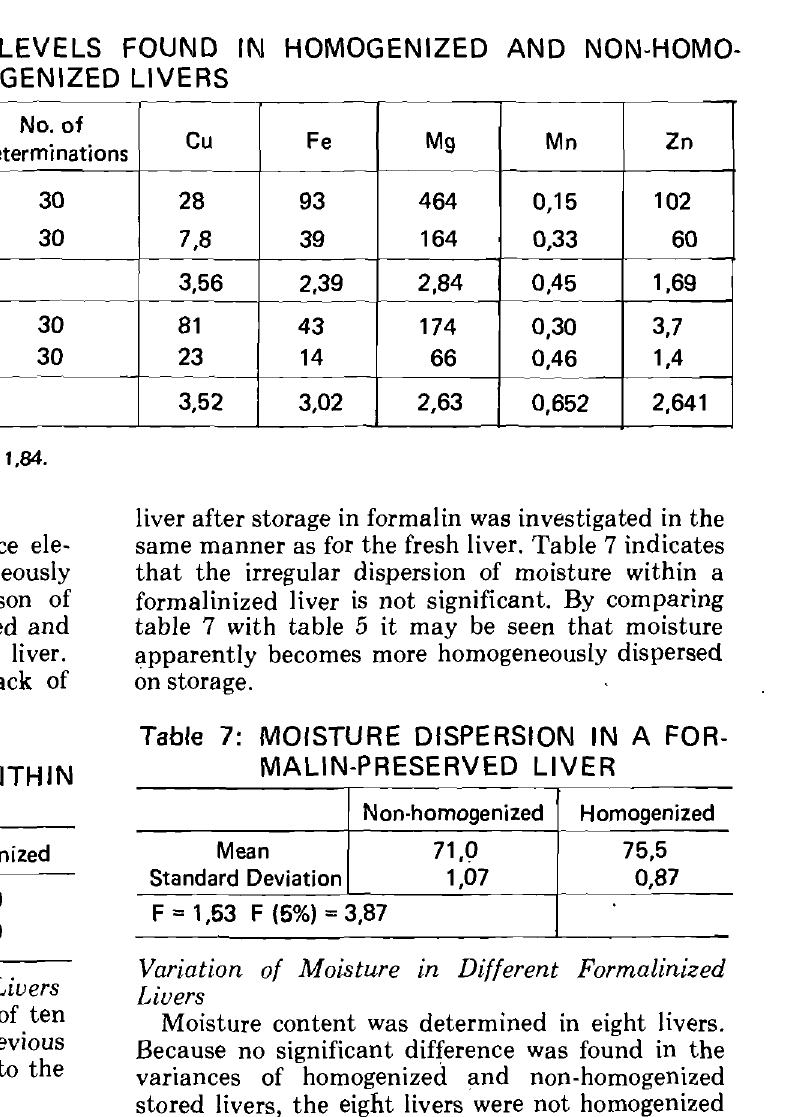
MOISTURE 'CONTENT OF FRESH HOMOGENIZED LIVERS